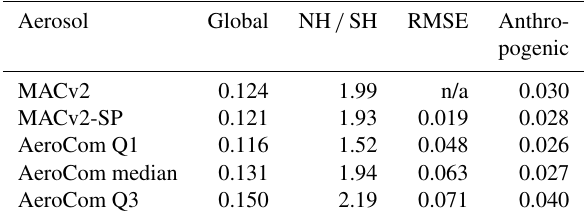
Table 7. Metrics of optical depth for the total (anthropogenic and natural) aerosol. Shown are the global values, the hemispheric ratio and the root mean square difference. For the AeroCom models, this is calculated with respect to the AeroCom mean; for MACv2-SP, this is calculated relative to MACv2. In the case of the total aerosol, for the AeroCom models, we consider 26 calculations and disregard the outliers by showing the values of the first and third quartiles and the median. For the anthropogenic aerosol, the tabulated results are taken from Table 2 of Myhre et al.